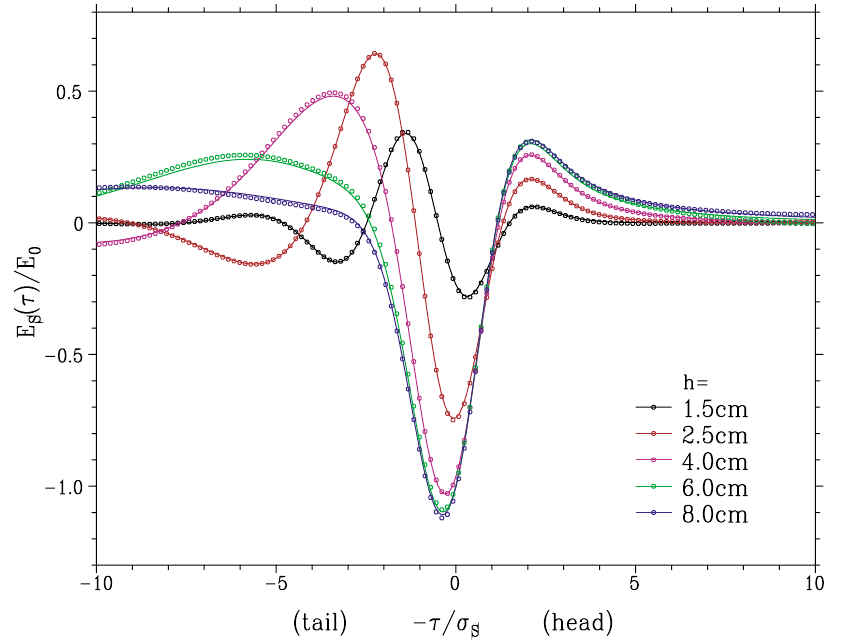
FIG. 2. (Color) The longitudinal electric field E in steady state at x (cid:1) y (cid:1) 0 between infinite parallel plates. Warnock’s formula is s plotted with solid lines. The dots are the simulation results. The different colors show the gap between the two horizontal parallel plates, h (cid:1) 1 : 5 cm (black), 2.5 cm (red), 4 cm (magenta), 6 cm (green), and 8 cm (blue), respectively. The width of the chamber is w (cid:1) 50 cm and the length of the magnet is 3 m.